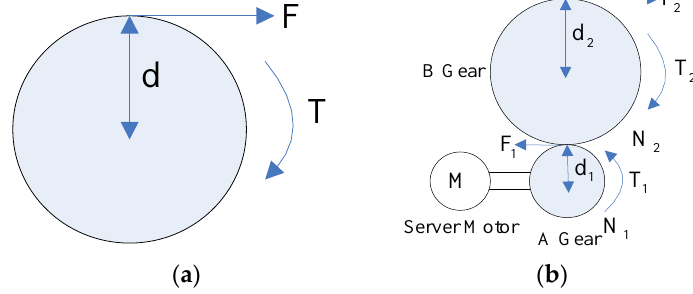
Figure 2. Relation of torque and gear. ( a ) Torque; ( b ) torque and gear.